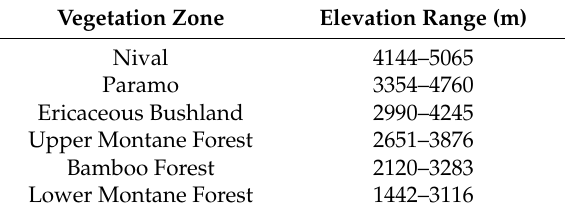
Table 3. Elevation ranges for each vegetation zone on Mount Kenya, from [38]